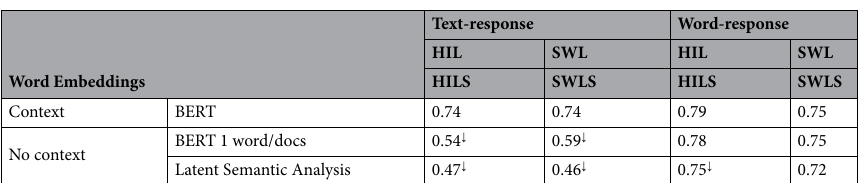
Table 2. Comparison of Pearson Correlations Using Contextualized versus Decontextualized Word Embeddings for Individual Word- and Text-Responses. All correlations were significant at p < .001. N = 608. HIL = Harmony in life; SWL = Satisfaction with life; S = Scale. Latent Semantic Analysis based on Google 5-gram, 512 dimensions; number of dimensions were optimized as described in 10 (i.e., based on previous state- of-the-art). ↓ = significantly smaller than BERT. See Table SM3 for more comparisons.